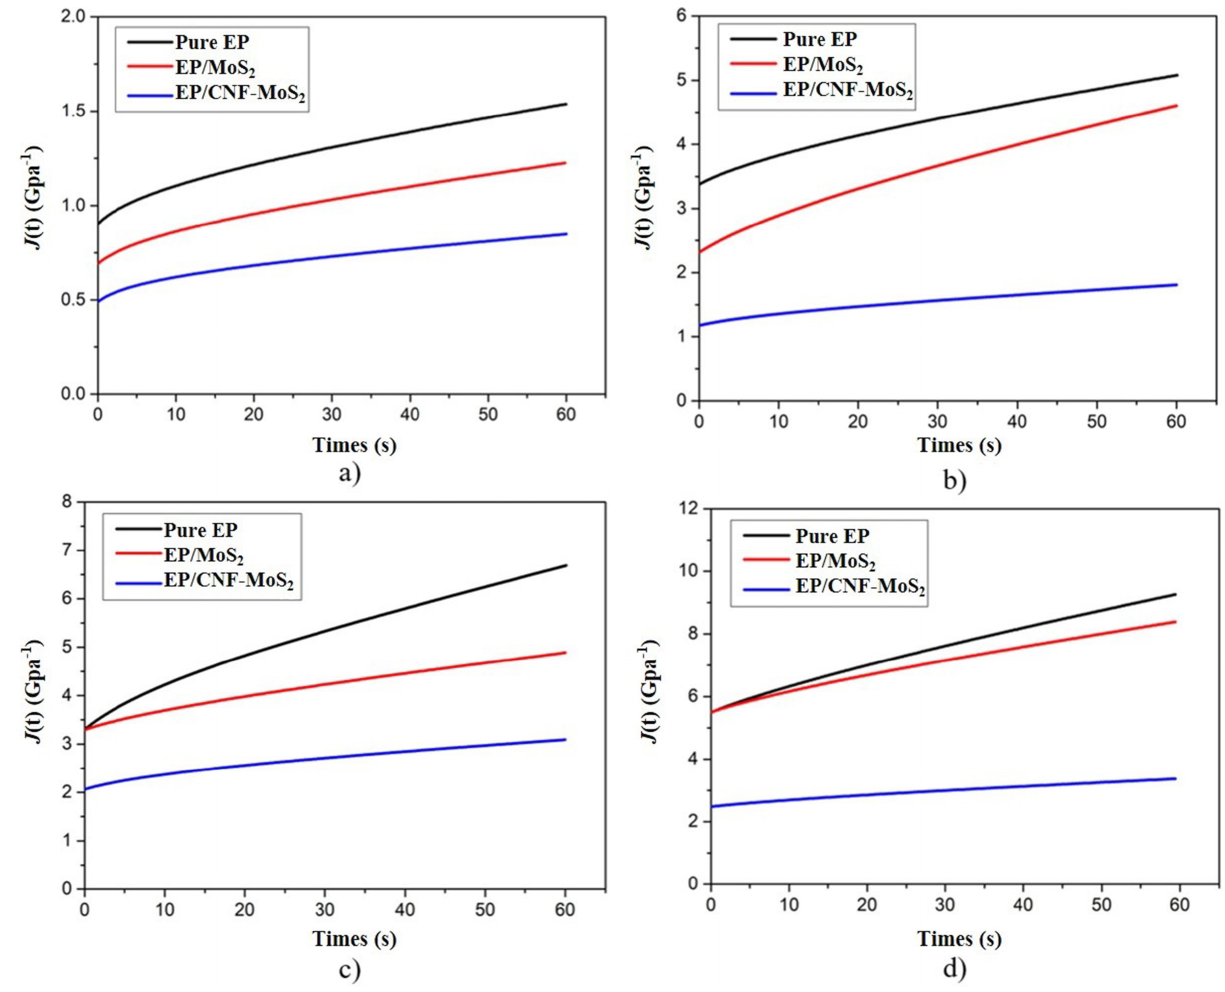
Figure 13: Creep compliance of coating specimens under different maximum load in the holding stage: a) 1 mN; b) 2 mN; c) 3 mN; d) 4